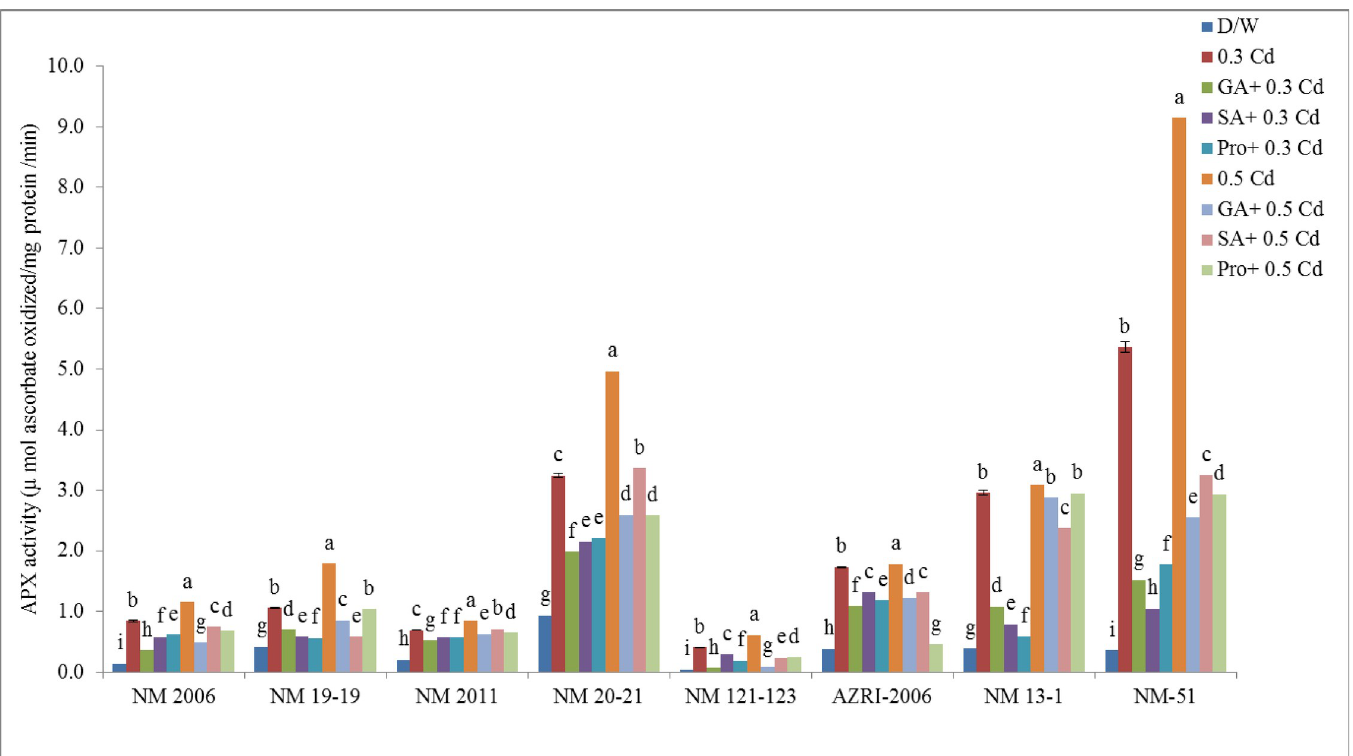
Fig 9. Specific activity of APX enzyme mung bean grown under Cd and pretreatments of GA 3 , SA and proline prior to Cd.